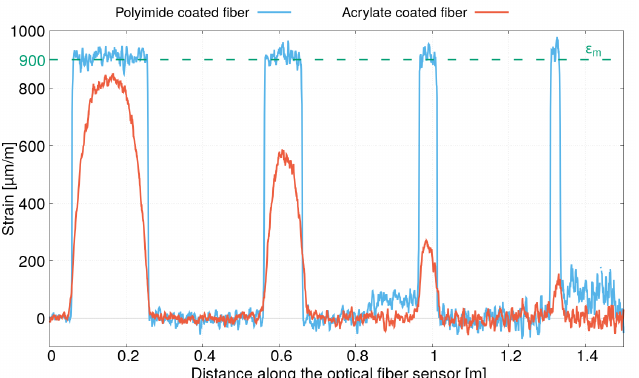
Figure 8. Strain profiles obtained for the sample instrumented by optical fibers with acrylate and polyimide coating under tensile test ( σ m = 180 MPa).